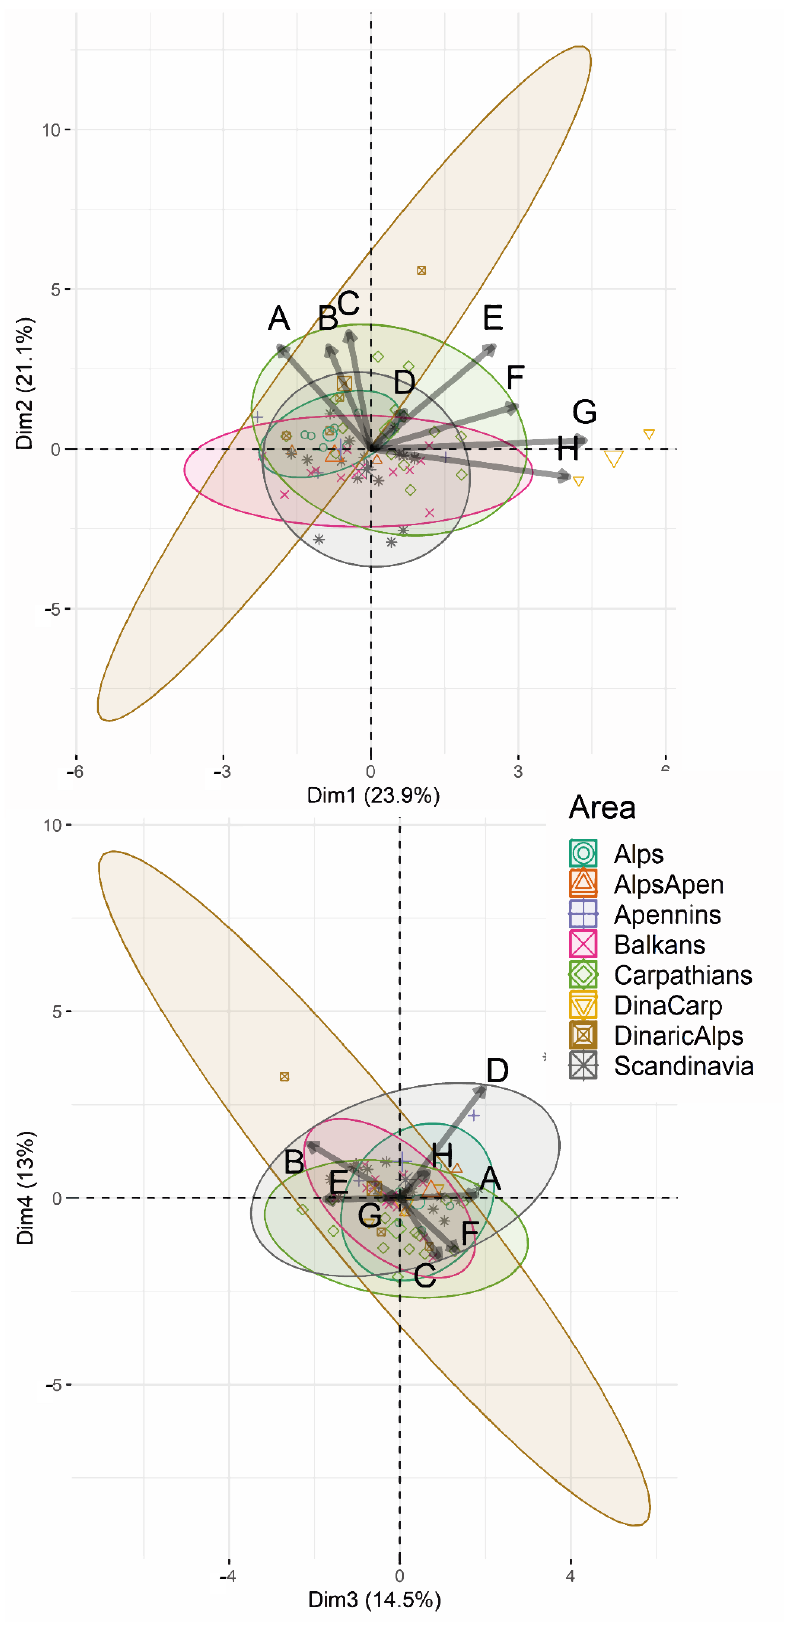
Figure A3. Biplot variables and individuals classed by study area (GDD – PCA).